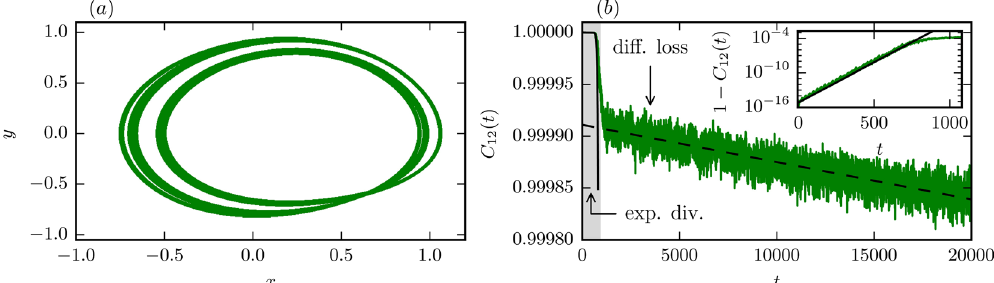
Figure 9. The attractor of the dynamical system described by Eq. (15), showing partially predictable chaos for b = 0.3783. ( a ) The projection to the x − y plane showing chaotic braids. ( b ) The cross-correlation C 12 , which decreases first exponentially (gray shaded region), as indicated by the fit . ⋅ For larger times the cross-correlation decreases linearly with a slope ∝ 3.6 · 10 − 9 t (dashed line).